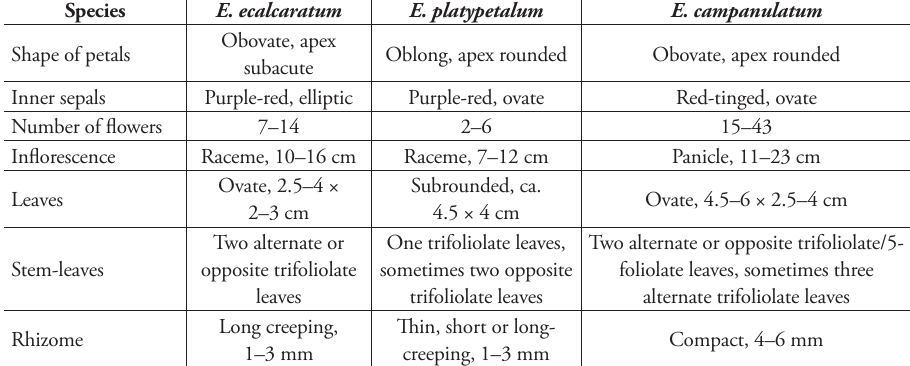
Table 4. Comparison of key characteristics of E. ecalcaratum , E. platypetalum , and E. campanulatum .